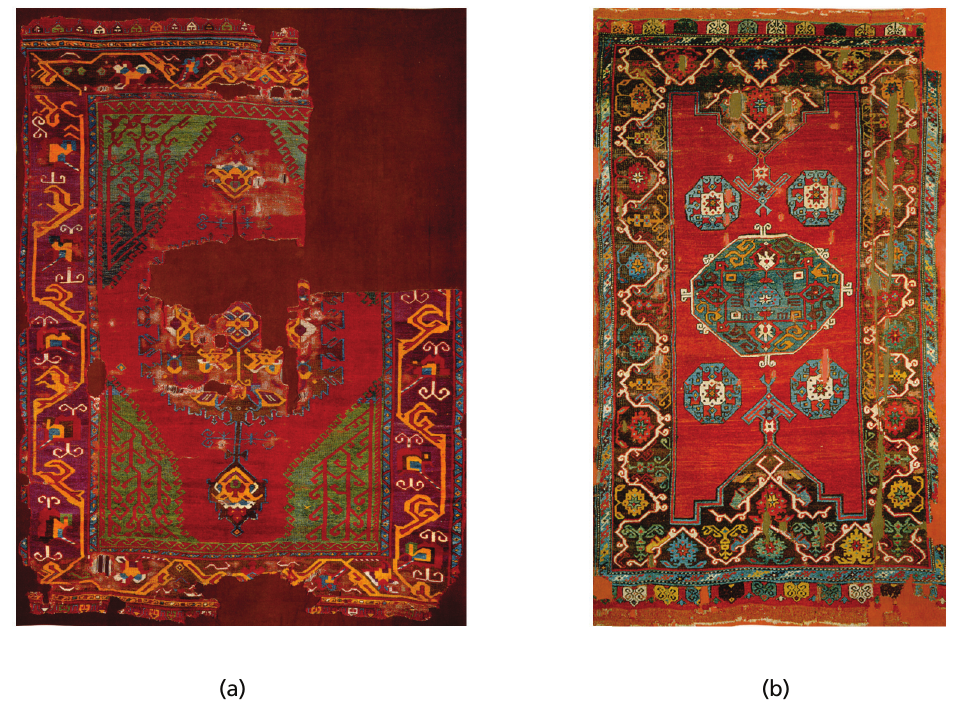
Figure 11. ( a ) Flowered carpet with giant central medallion from Karapinar (page 231); ( b ) waving border carpet from Konya district (page 193) Source: { Foreshadowing }